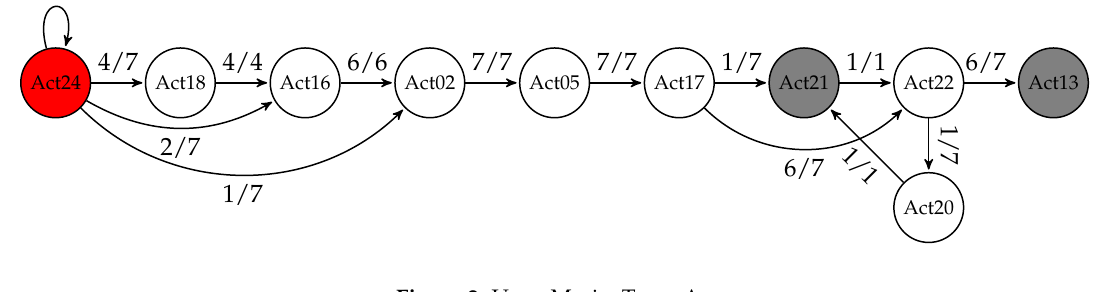
Figure 2. User: Mario, Type: